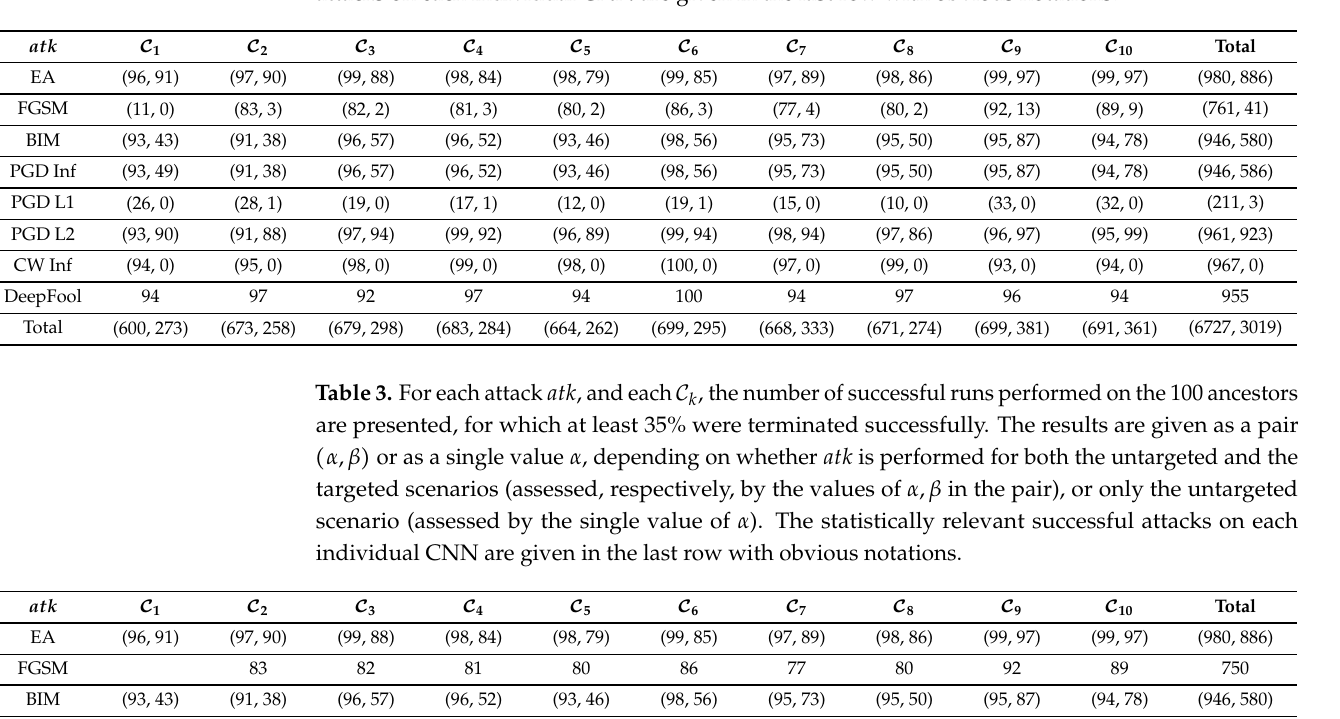
Table 2. For each attack atk , and each C k , the number of successful runs performed on the 100 ancestors are presented. The results are given as a pair ( α , β ) or as a single value α , depending on whether atk is performed for both the untargeted and the targeted scenarios (assessed, respectively, by the values of α , β in the pair), or only the untargeted scenario (assessed by the single value of α ). The successful attacks on each individual CNN are given in the last row with obvious notations.